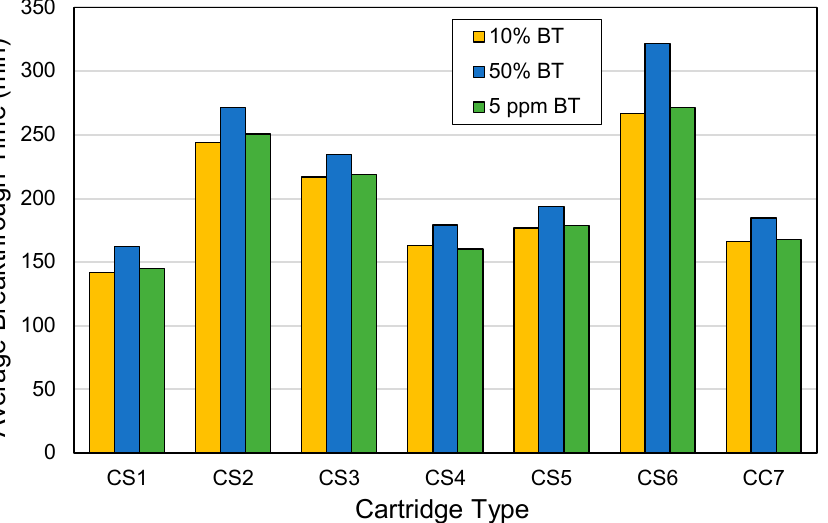
Figure 6. Average breakthrough times by cartridge type. Cartridge type (ACF composition): CS1 (100% AF1); CS2 (100% AF2); CS3 (100% AF3); CS4 (100% AF4); CS5 (100% AF5); CS6 (100%